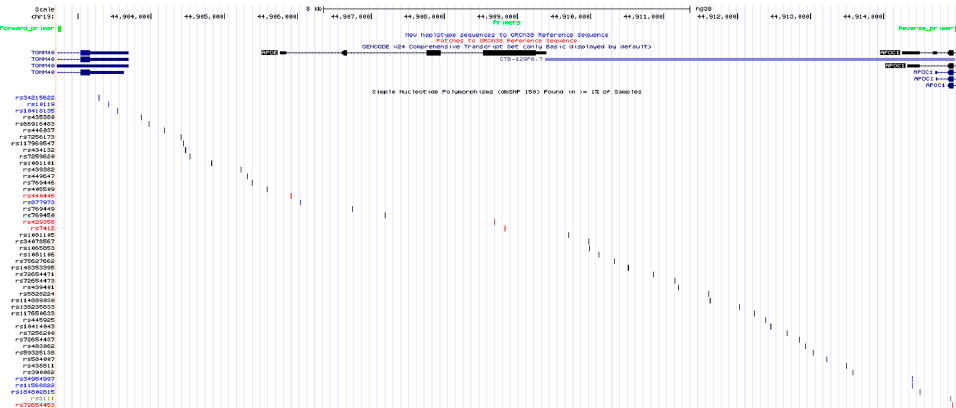
Figure 1. Target region selected for this the study. The genomic region chr19:44,902,730–44,915,006 (hg38) visualized in the UCSC Genome Browser, identifying the single-nucleotide polymorphisms (SNVs) included in dbSNP. SNVs indicated with gray ticks represent synonymous variants in coding regions. SNVs indicated with red ticks represent non-synonymous variants in coding regions. SNVs indicated with blue ticks represent variants in untranslated regions. SNVs indicated with black ticks represent either variants in intronic regions or upstream/downstream gene variants. The positions of the PCR primers are shown in green.